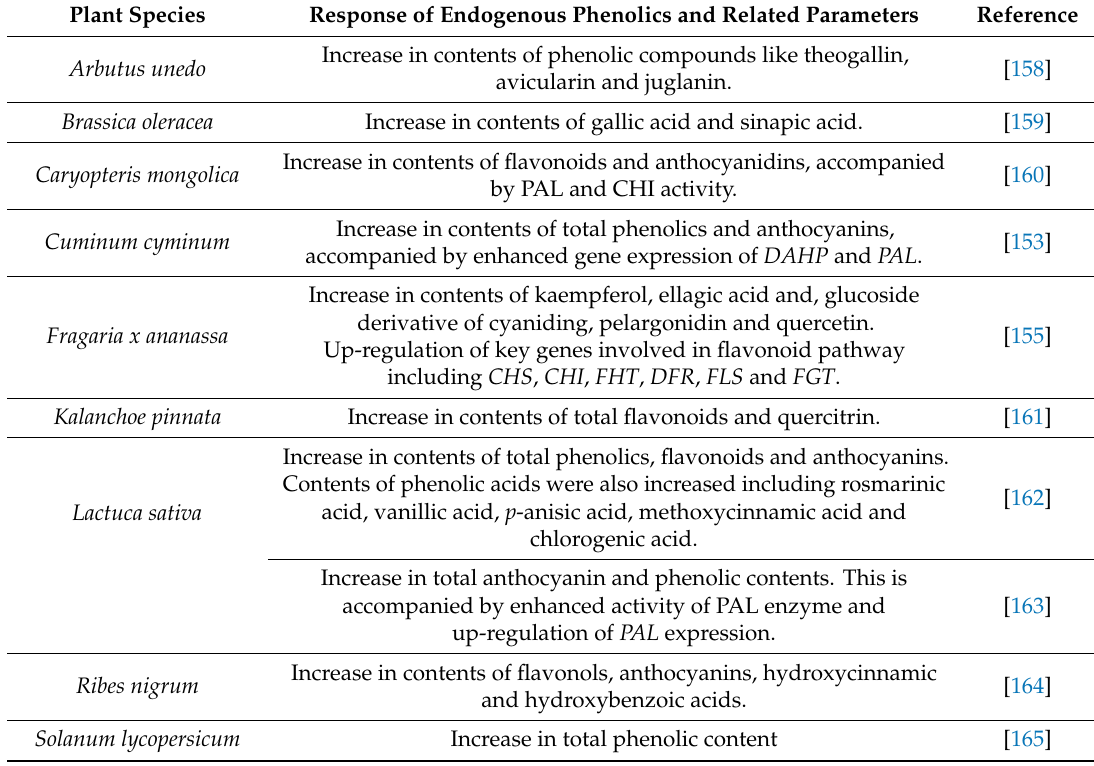
Table 4. Summary table describing the impact of UV light exposure on the endogenous levels of various phenolic compounds in